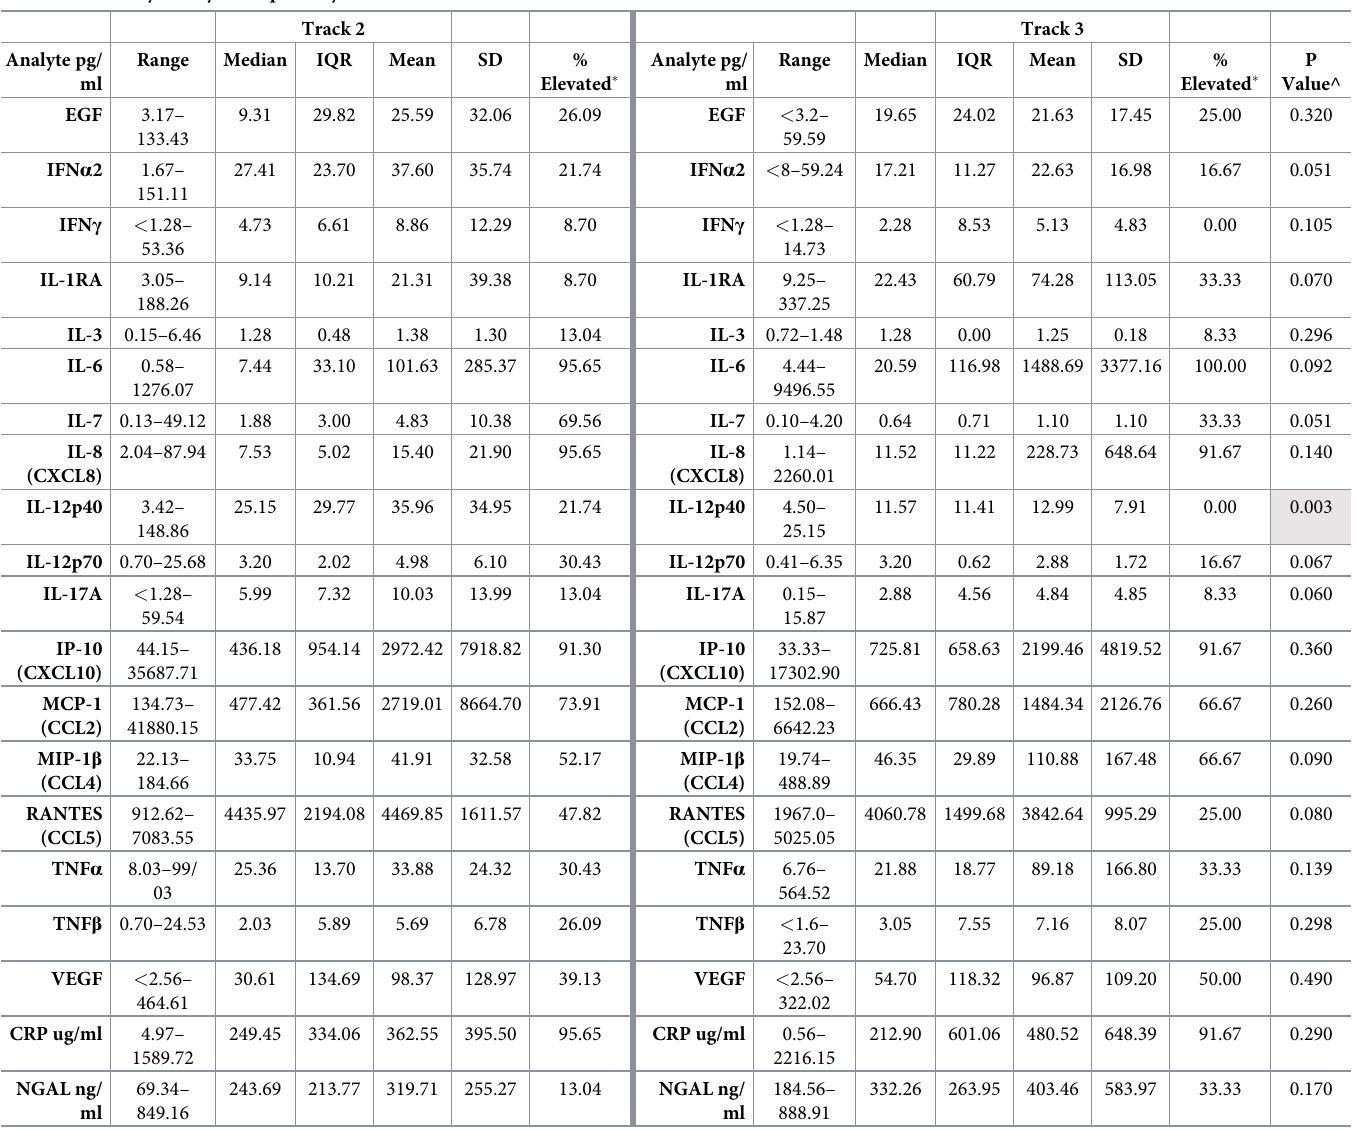
Table 5. Summary of Day 3 Recipient Cytokine Levels of